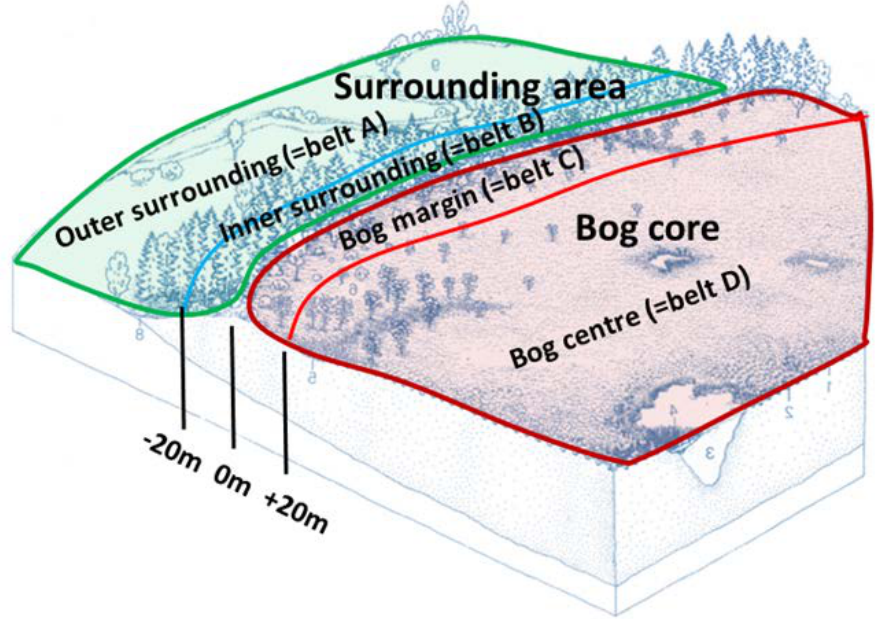
Figure 2. The four concentric belts within bog sites (adapted from Grünig et al . 1986). surroundings) covered the surrounding area up to 20 m from the edge of the bog core. Belt B (inner surroundings) covered the surrounding area from 20 m outside the bog core to its edge. Belt C (bog margin) covered the bog core from the edge up to 20 m inside the bog core and Belt D (bog centre) covered the bog centre, i.e. the area situated inside the bog core at a distance of more than 20 m from the edge of the bog